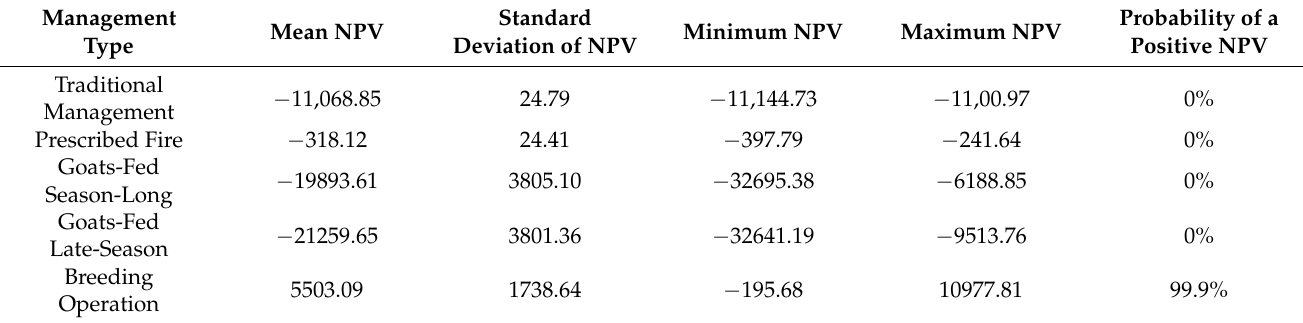
Table 2. Table of simulated NPV results for the four management options